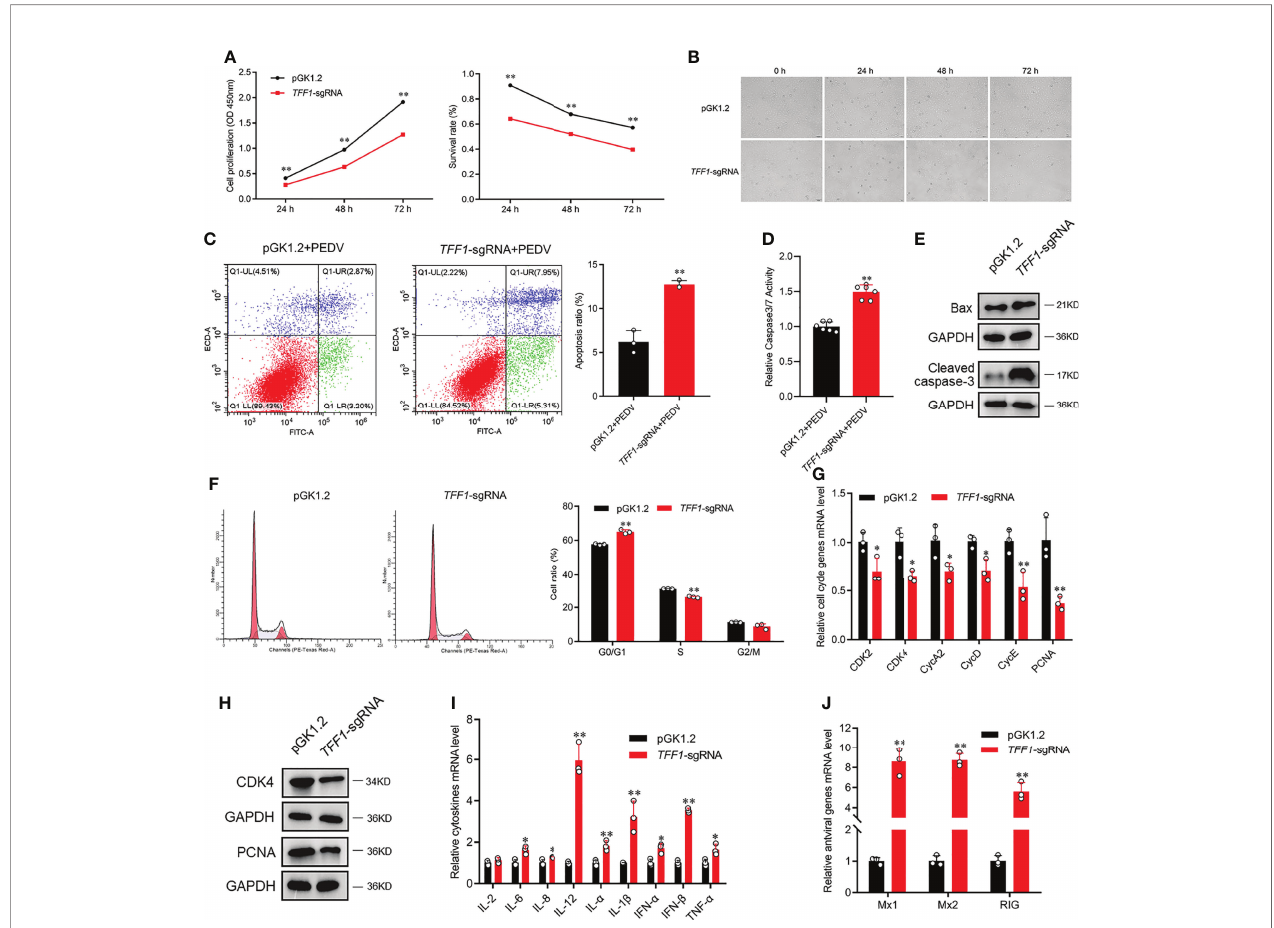
FIGURE 3 | TFF1 reduces PEDV-induced intestinal in fl ammation. (A) The proliferation and cytotoxicity of TFF1 -knockout were detected by CCK-8 assay in IPEC-J2. (B) Morphological changes in TFF1- knockout cells after PEDV infection for 0, 24, 48 and 72 hours. (C, D) Cell apoptotic was detected by caspase3/7 activity and fl ow cytometry. (E) Protein levels of cell proliferation regulators were detected by western blotting in response to PEDV infection at MOI of 0.1 in TFF1 -knockout cells. (F) Cell cycle distribution was detected by fl ow cytometry. (G, H) mRNA and protein levels of cell cycle genes were determined in TFF1 -sgRNA cell. (I, J) mRNA expression of in fl ammatory cytokines and antiviral genes were detected after PEDV infection at MOI of 0.1 in TFF1 -sgRNA cells. Data are presented as mean values ± SD, using two tailed Student ’ s t-test . * p < 0.05, ** p < 0.01. Each treatment has triplicate biological replicates at